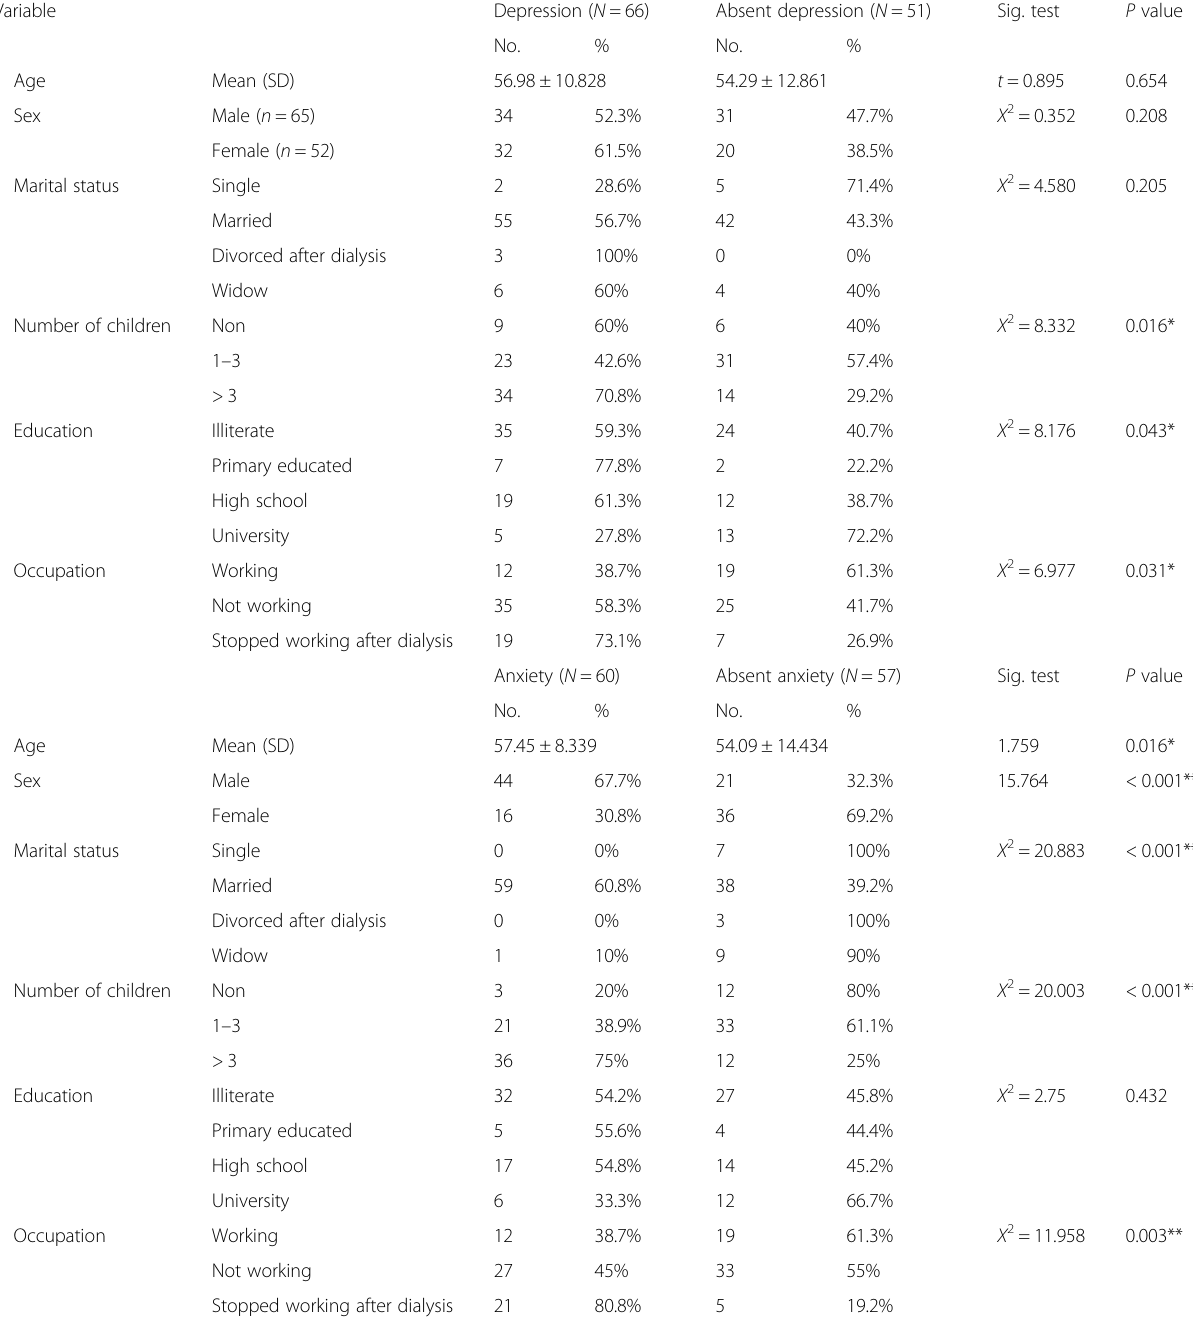
Table 2 Relation between sociodemographic data and psychiatric comorbidity in end stage renal diseases patients